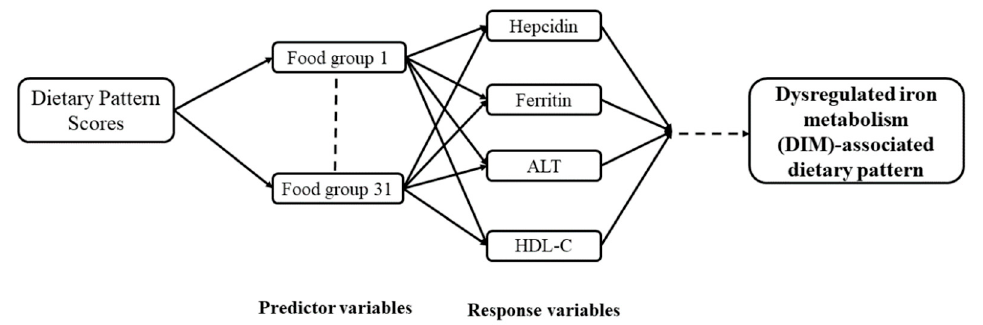
Figure 1. Direct acyclic graph of the reduced-rank regression (RRR) conceptual framework. ALT, alanine aminotransferase; HDL-C, high-density lipoprotein cholesterol.